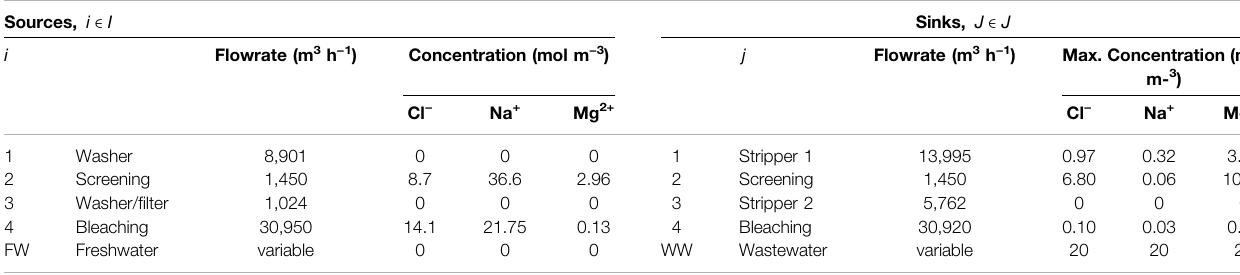
TABLE 2 | Data for sources and sinks.